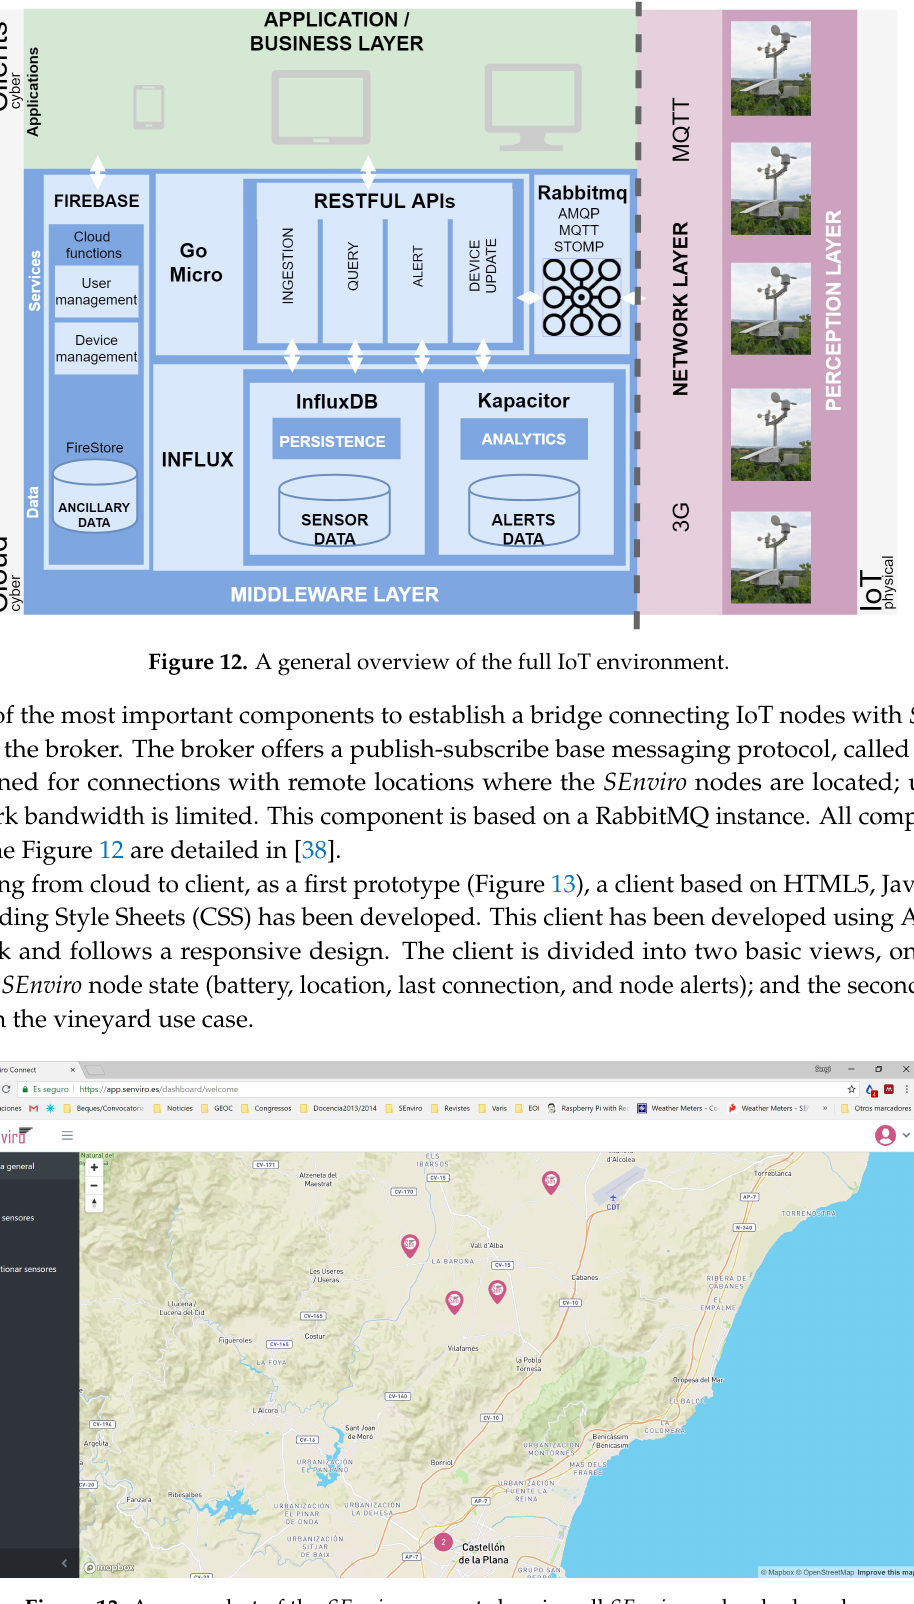
Figure 13. A screenshot of the SEnviro connect showing all SEnviro nodes